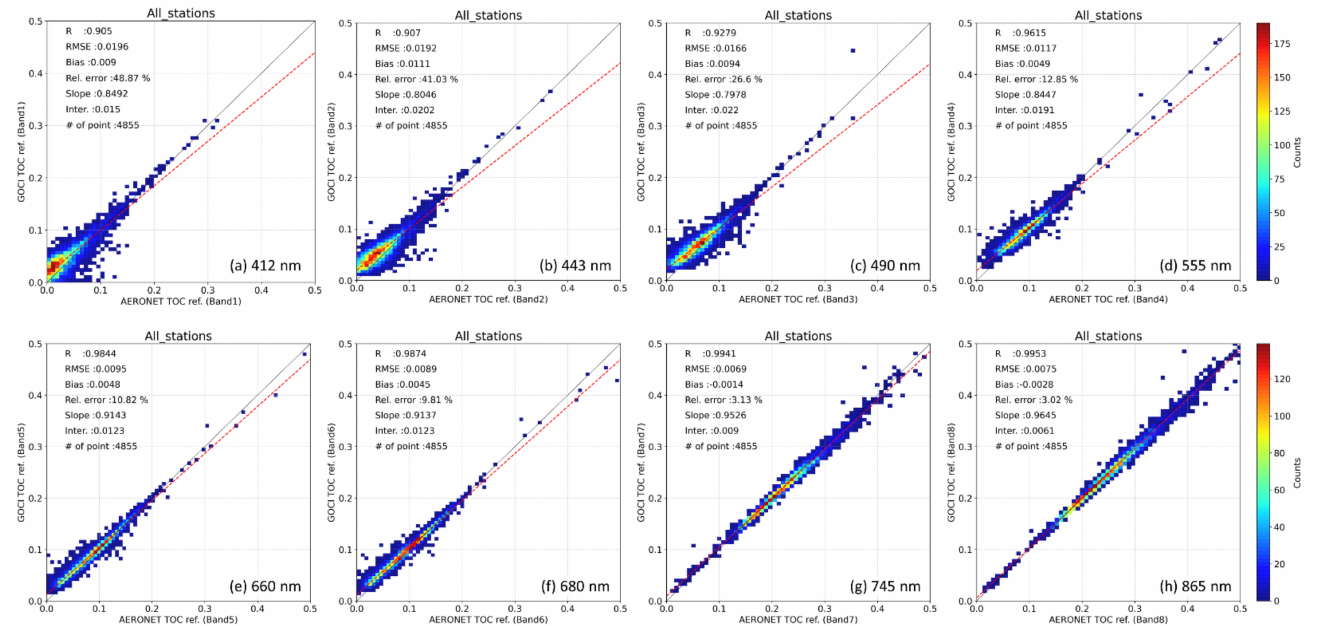
Figure 4. Density plot of estimated GOCI LSR and in situ reference data for each channel: ( a ) band 1; ( b ) band 2; ( c ) band 3; ( d ) band 4; ( e ) band 5; ( f ) band 6; ( g ) band 7; ( h ) band 8. The color indicates the point density in each bin (0.01 by 0.01), and the red dashed line is the regression